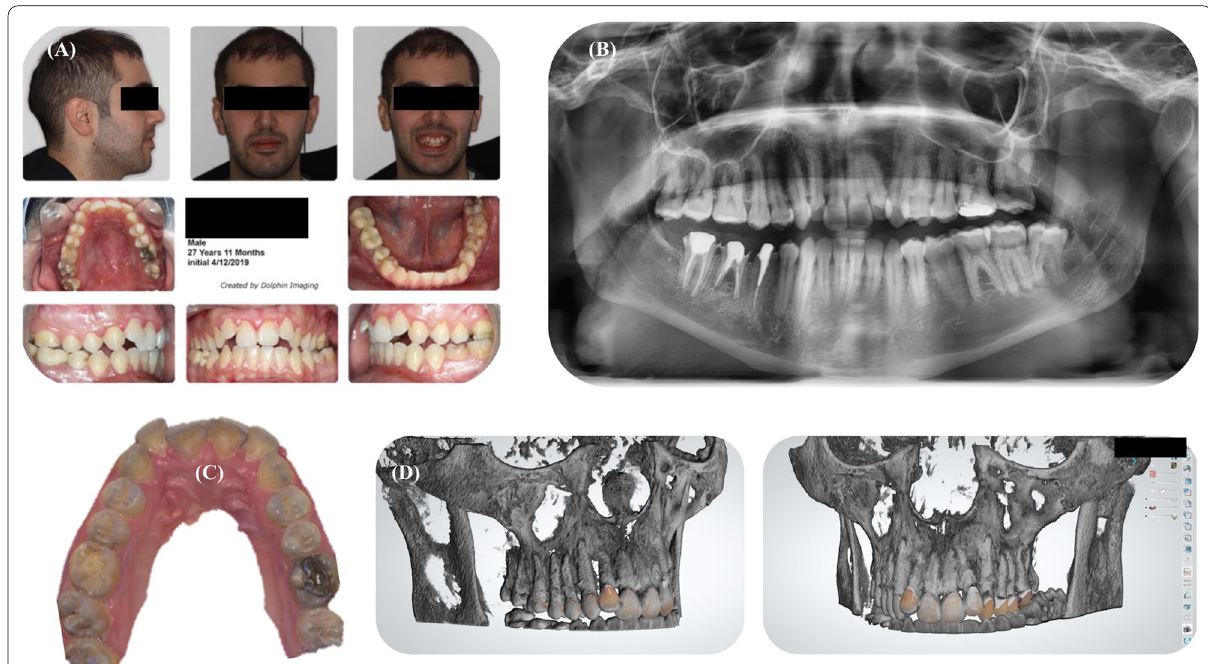
Fig. 1 Pretreatment data of the patient. A Intra-oral and extra-oral photographs of the patient. B Panoramic radiograph. C Maxillary intra-oral scan. D Superimposition of the CBCT and the impression using OrthoAnalyzer ™